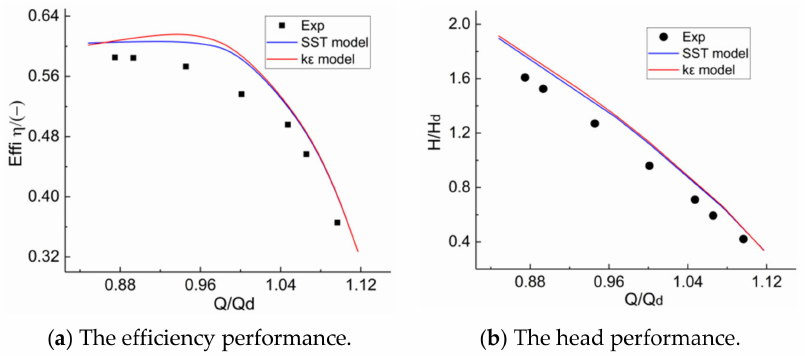
Figure 5. Comparison of the performances between the simulation and